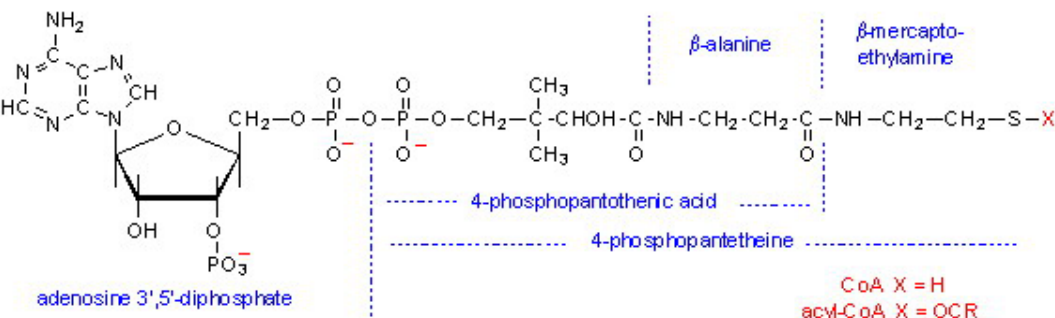
Figure 1. Structure of Coenzyme